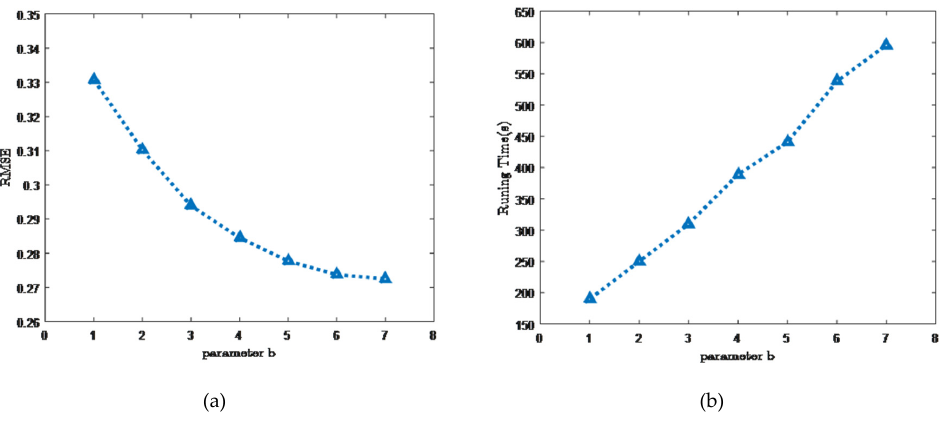
Figure 9. Selection of the PG-NLSR parameter b (the number of similar pixels in a pixel group): ( a ) RMSE index; and ( b ) Running time in seconds.